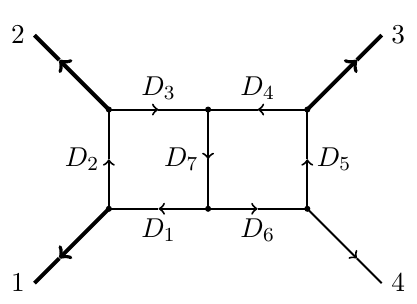
Figure 2 . The two-loop double box Feynman integral with three massive external momenta k 1 , k 2 , k 3 and seven massless propagators. The massive legs are indicate by thick